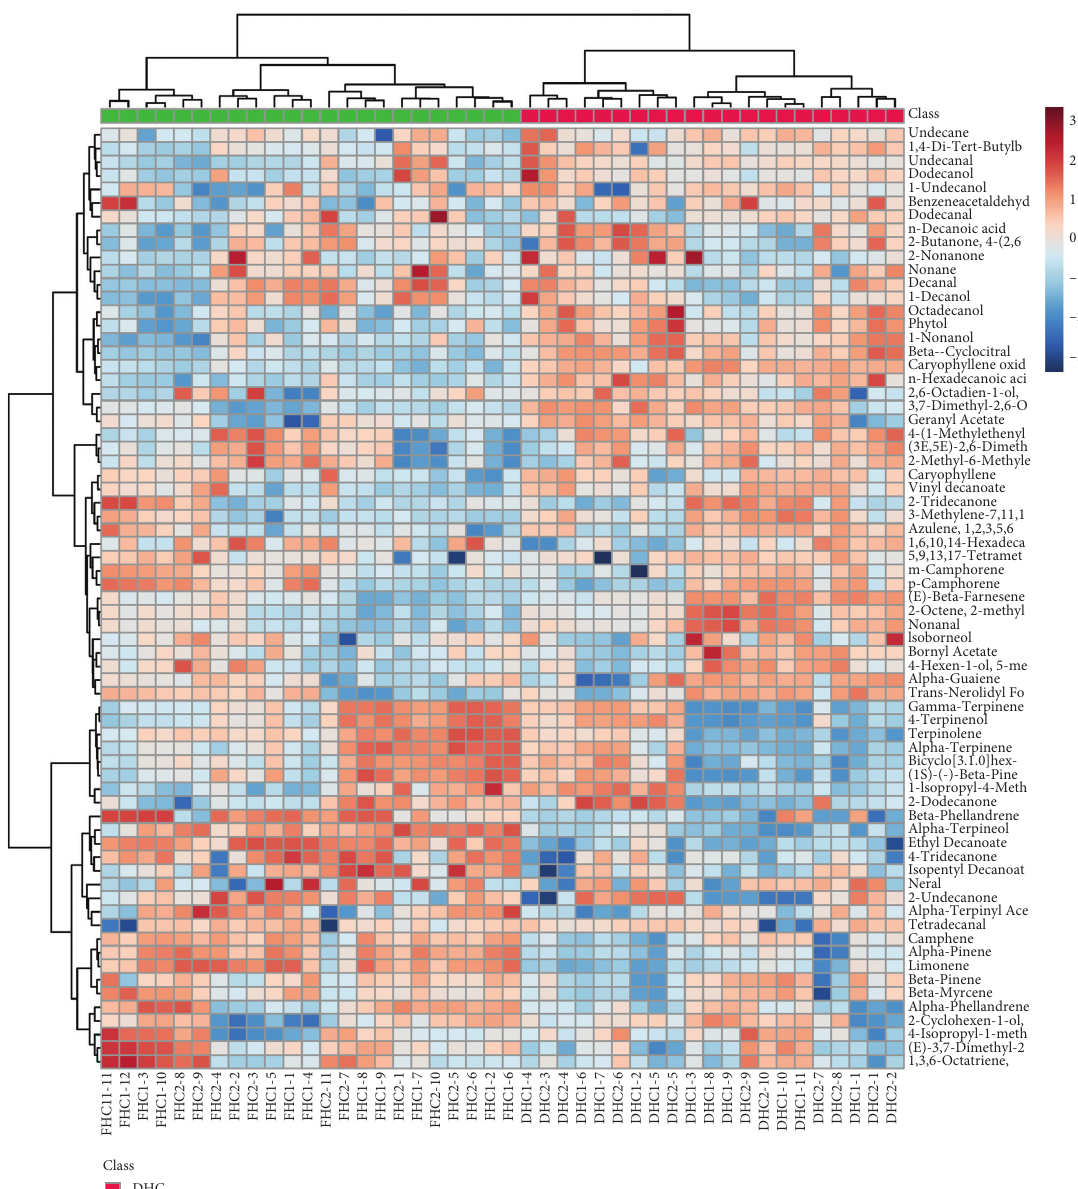
Figure 3: Heatmap analysis and HCA analysis of twenty-one batches of DHC and twenty-three batches of FHC at two harvest seasons. The different degrees of color clearly indicate the relationship between these chemical components in different